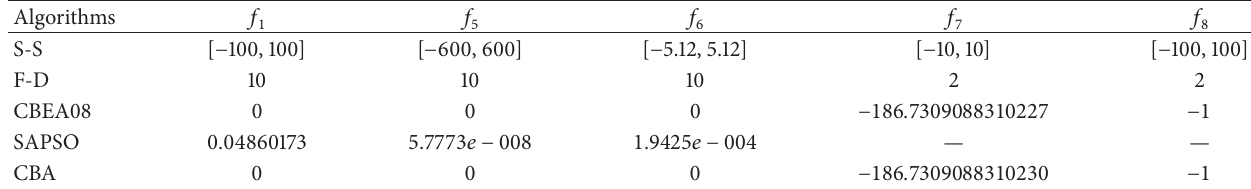
Table 3: Experimental results comparison between CBEA08, CBA, and SAPSO.